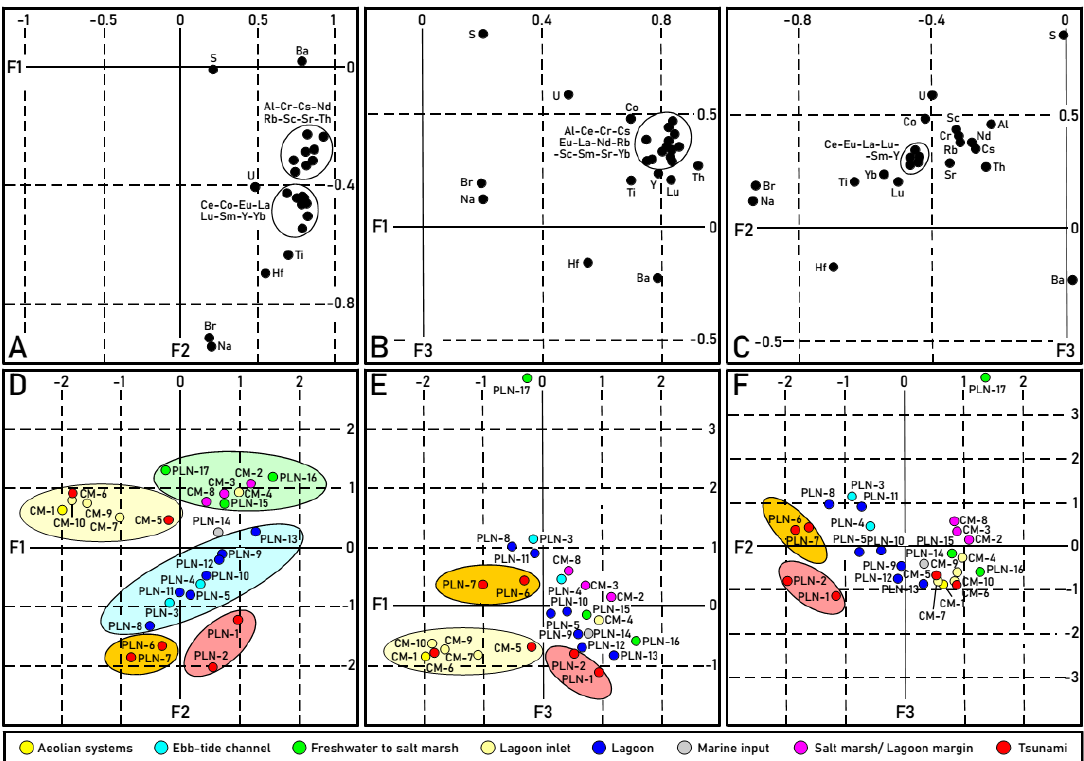
Figure 9. Trace elements: factor analysis. ( A – C ) elements. ( A ) F1–F2 diagram; ( B ) F1–F3 diagram; ( C ) F2–F3 diagram. ( D – F ) samples. ( D ) F1–F2 diagram; ( E ) F1–F3 diagram; ( F ) F2–F3 diagram.